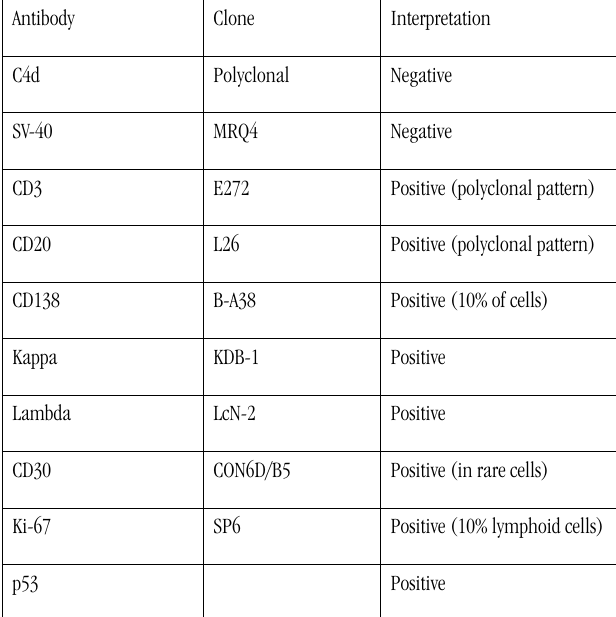
TABLE 1 - Immunohistochemical panel of renal